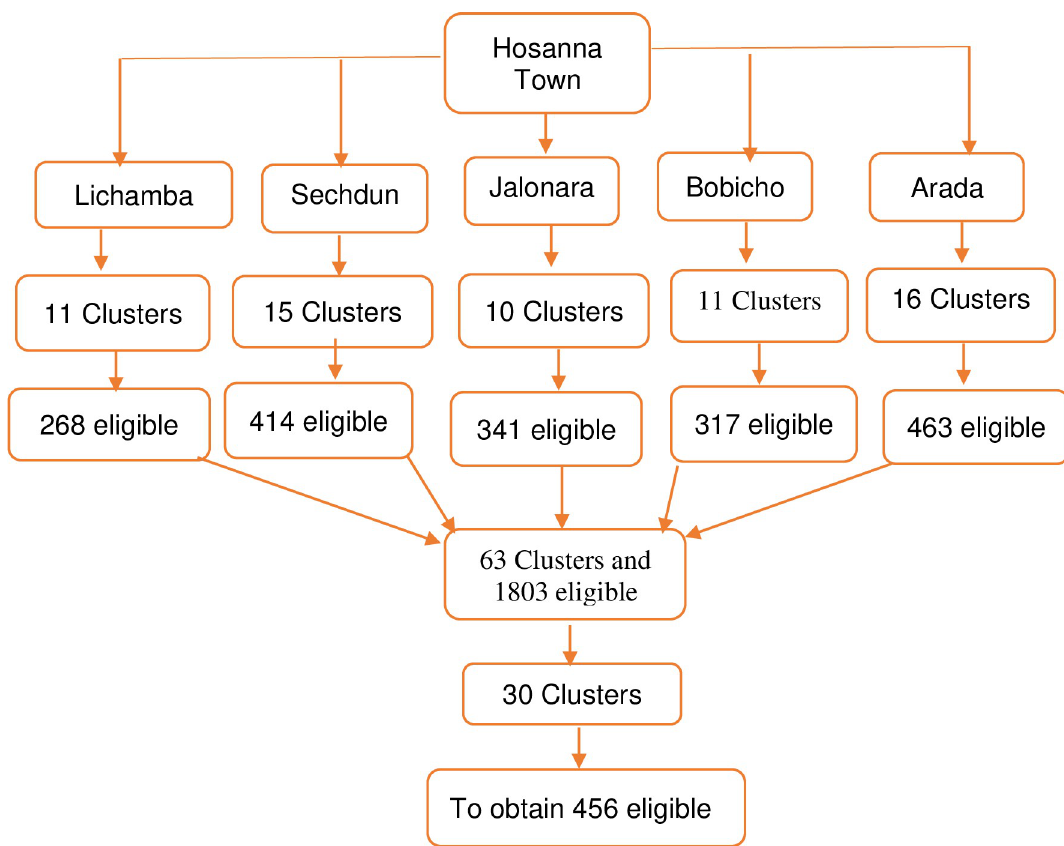
Fig 1. Diagrammatic representation of sampling technique, Hosanna town,